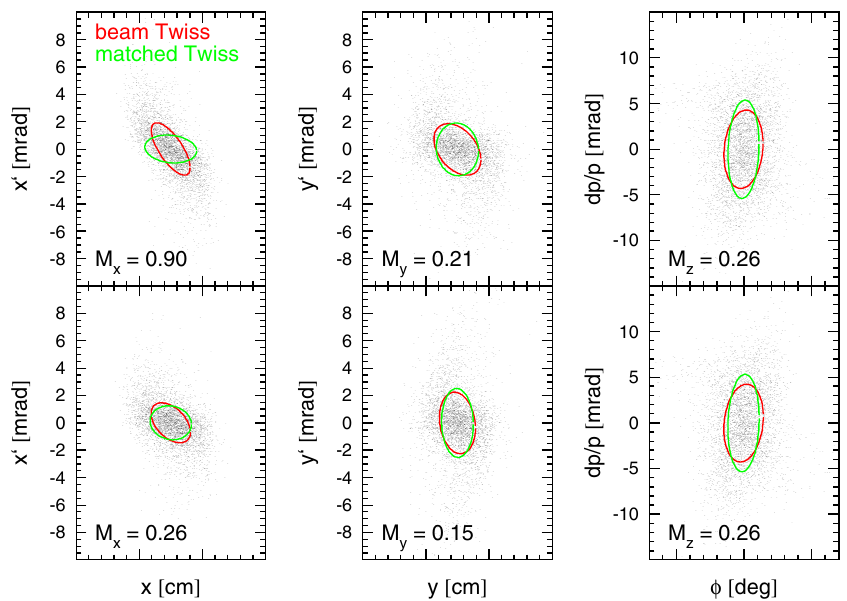
FIG. 20. (Color) Phase space distributions from DYNAMION simulations at the entrance to the DTL for different zero current phase advances (cid:4) o (upper: 35 (cid:1) ; lower: 50 (cid:1) ). The ellipses correspond to 95%-rms-Twiss parameters of the distributions (red) and to the rms- matched injection into the DTL (green). Phases refer to 108